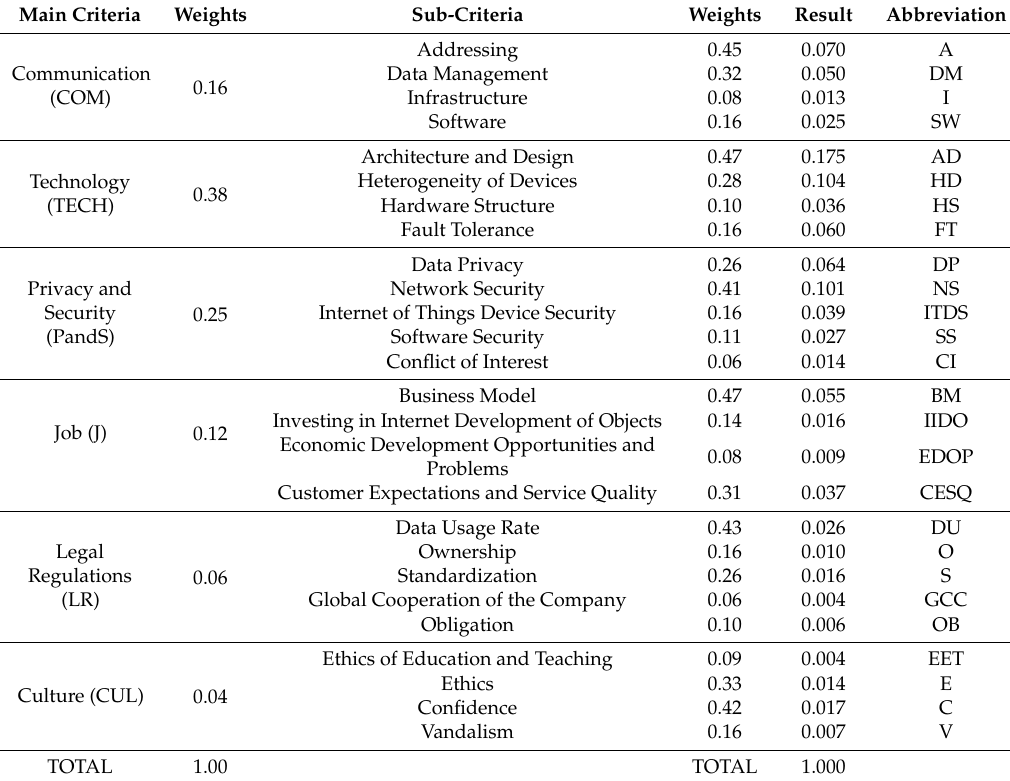
Table 5. Criteria weights obtained by the analytic hierarchy process (AHP)